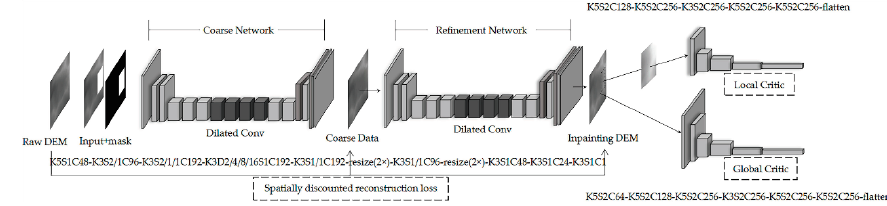
Figure 1. Network structure schematic.